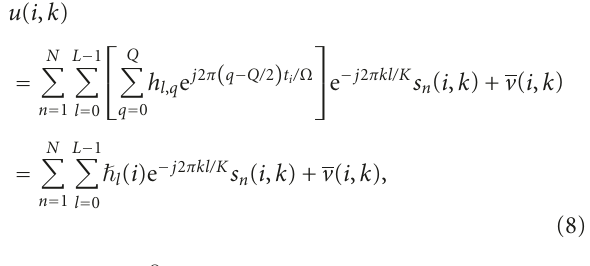
Figure 2: Superimposed training sequences of di ff erent users are distributed over the whole frequency band of OFDMA uplink